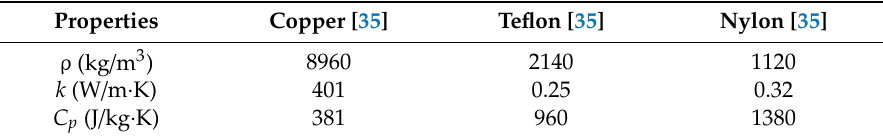
Table 1. Physical properties of the materials used for the experimental